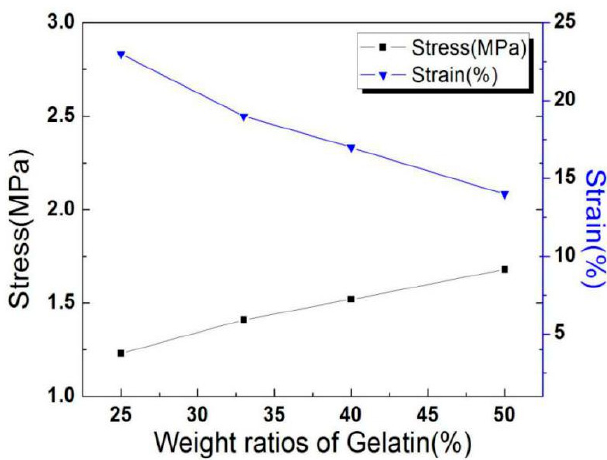
Figure 7. The relationship between the stress and strain of electrospun gelatin / pullulan composite membranes and the weight ratios of gelatin (total polymer concentration = 25% w / v ).